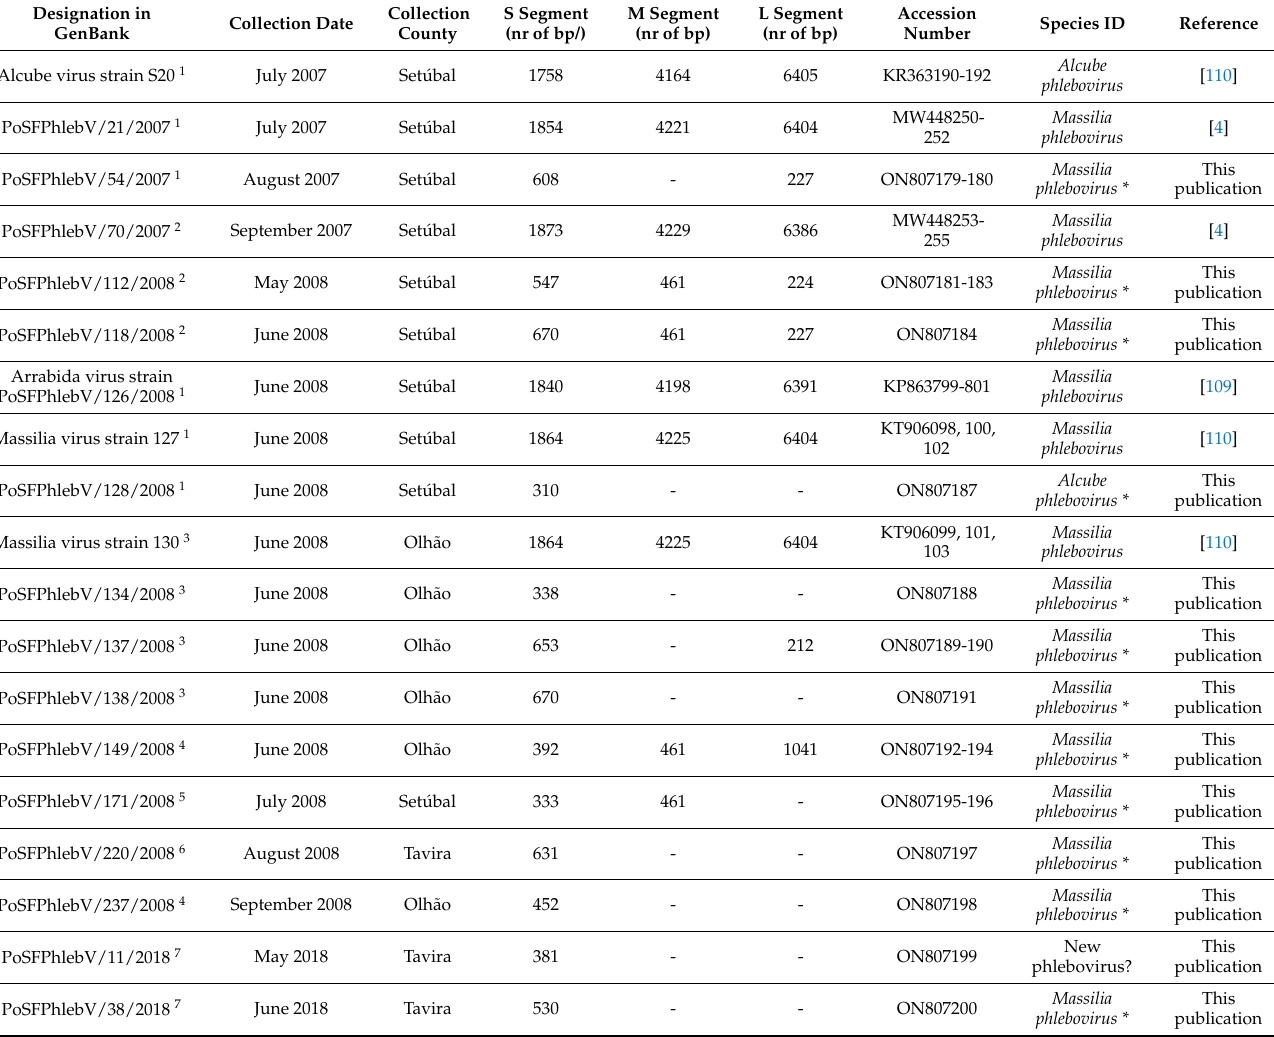
Table 1. Phleboviruses detected and/or isolated from sandfly pools in